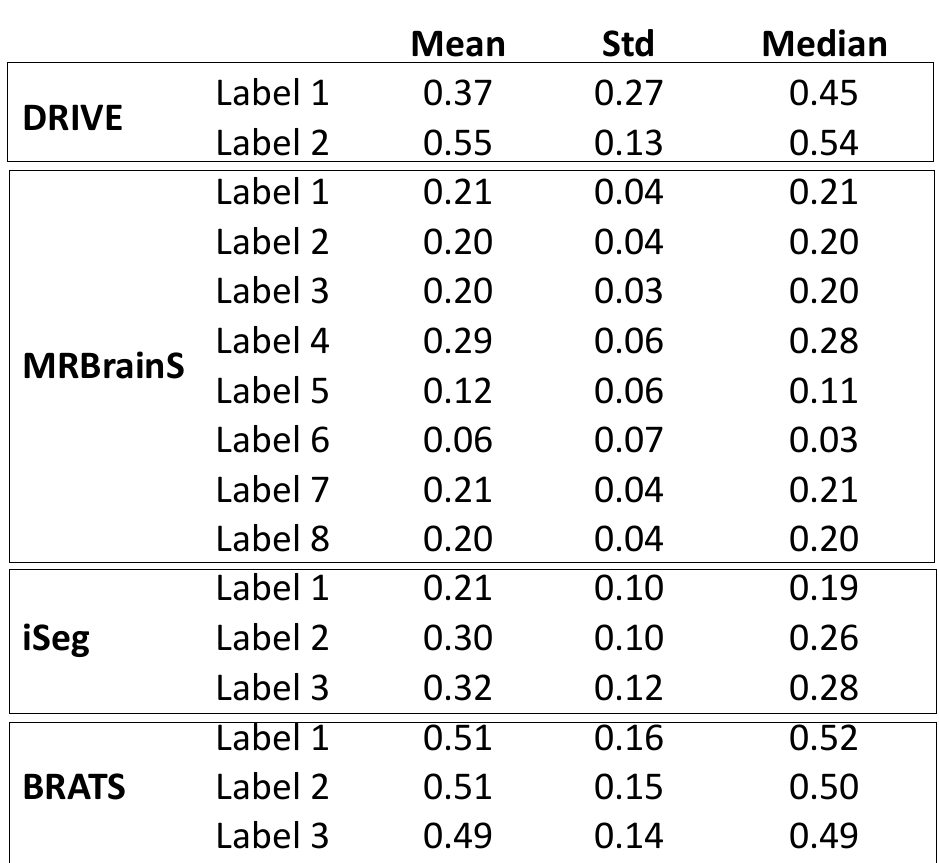
Figure 3. Image contrast shown in Mean/Std/Mean of pixel